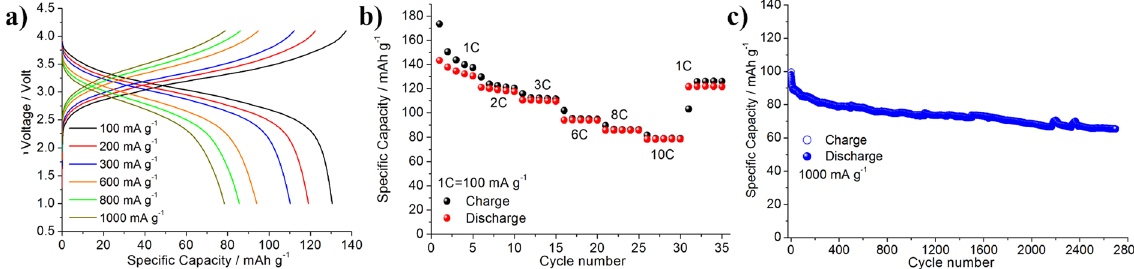
Figure 3. ( a ) Voltage profiles, ( b ) rate performance and ( c ) extended cycling-performance at 1000 mAg − 1 of the TiO 2 -B/LP30/LNMO Li-ion